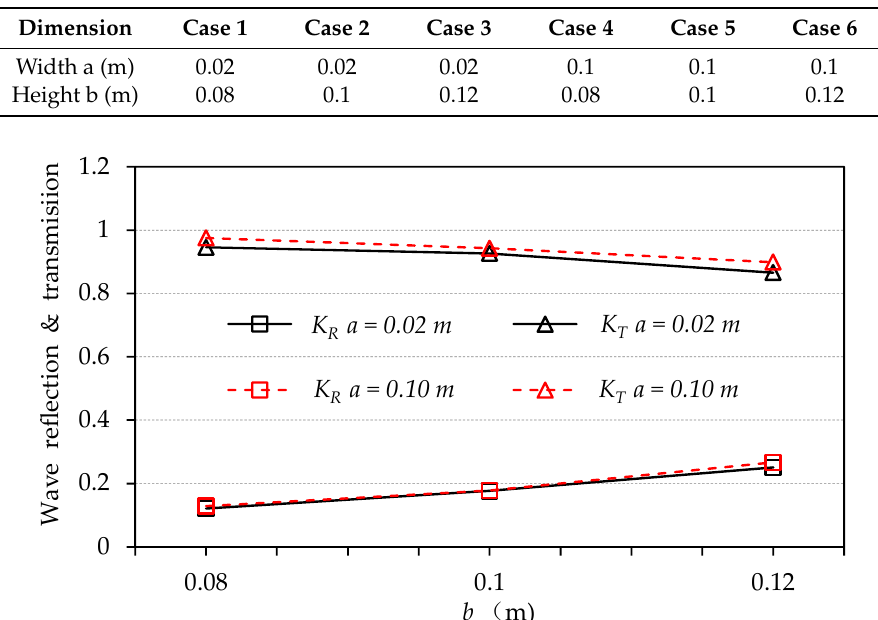
Figure 9. Wave transmission and reflection coefficients with breakwaters of difference dimensions.